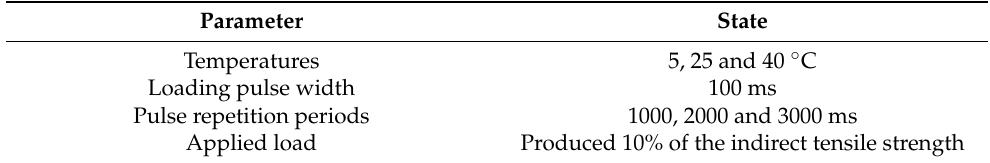
Table 4. Indirect tensile resilient modulus parameters. Parameter State